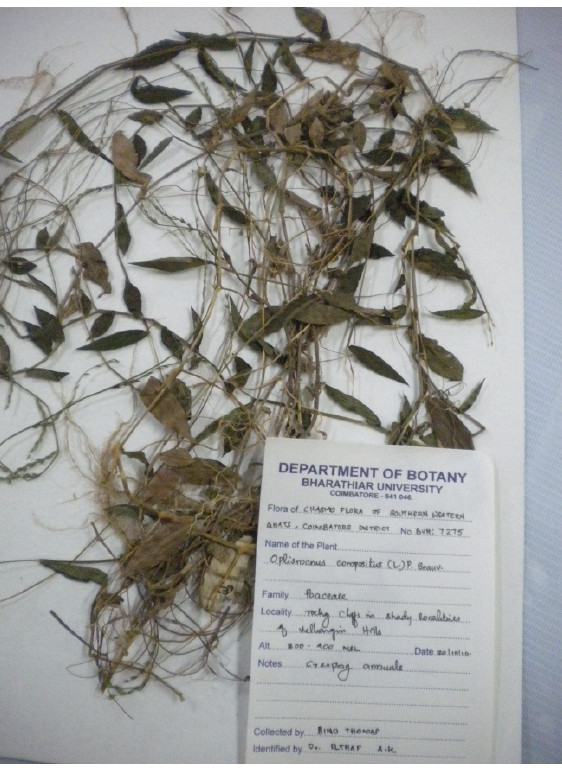
Image 24. Oplismenus compositus (L.) P. Beauv. Image 25. Panicum curviflorum Hornem.